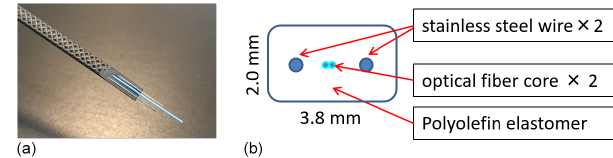
Figure 3. (a) Photo and (b) structure of the optical fiber